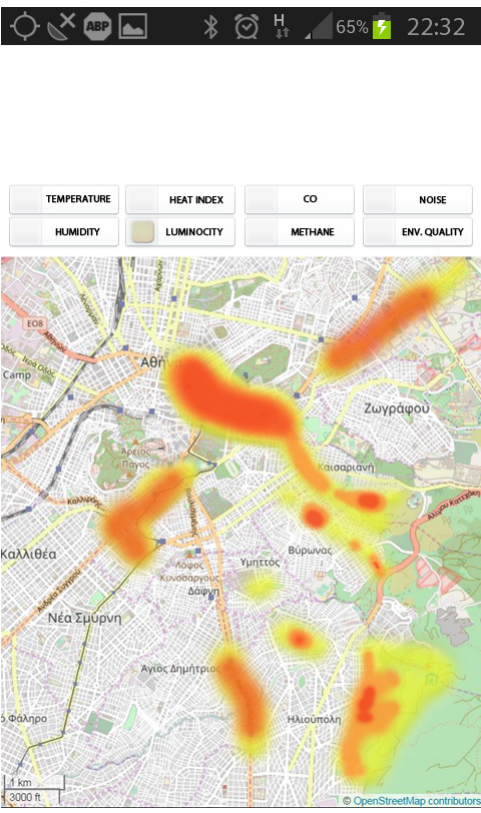
Figure 6. Luminosity map,